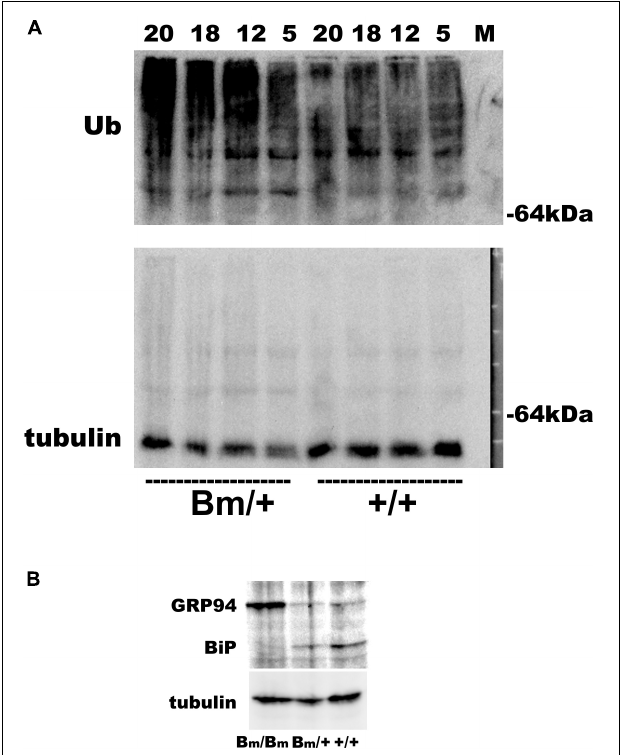
FIGURE 2 | Ubiquitinated proteins are more obvious in the spinal cord of mutant BiP mice. (A) Spinal cords from wild-type mice (+/+, 5, 12, 18, and 20 months old) and littermate heterozygous mutant BiP mice (Bm/+, 5, 12, 18, and 20 months old) were subjected to western blot analysis with an anti-ubiquitin or an anti-tubulin antibody followed by the secondary antibody. (B) Brains from wild-type neonate (+/+), and heterozygous (Bm/+) and homozygous (Bm/Bm) mutant BiP neonates were subjected to western blot analysis with an anti-KDEL or an anti-tubulin antibody. The anti-KDEL antibody recognizes the KDEL sequence of BiP as well as GRP94.